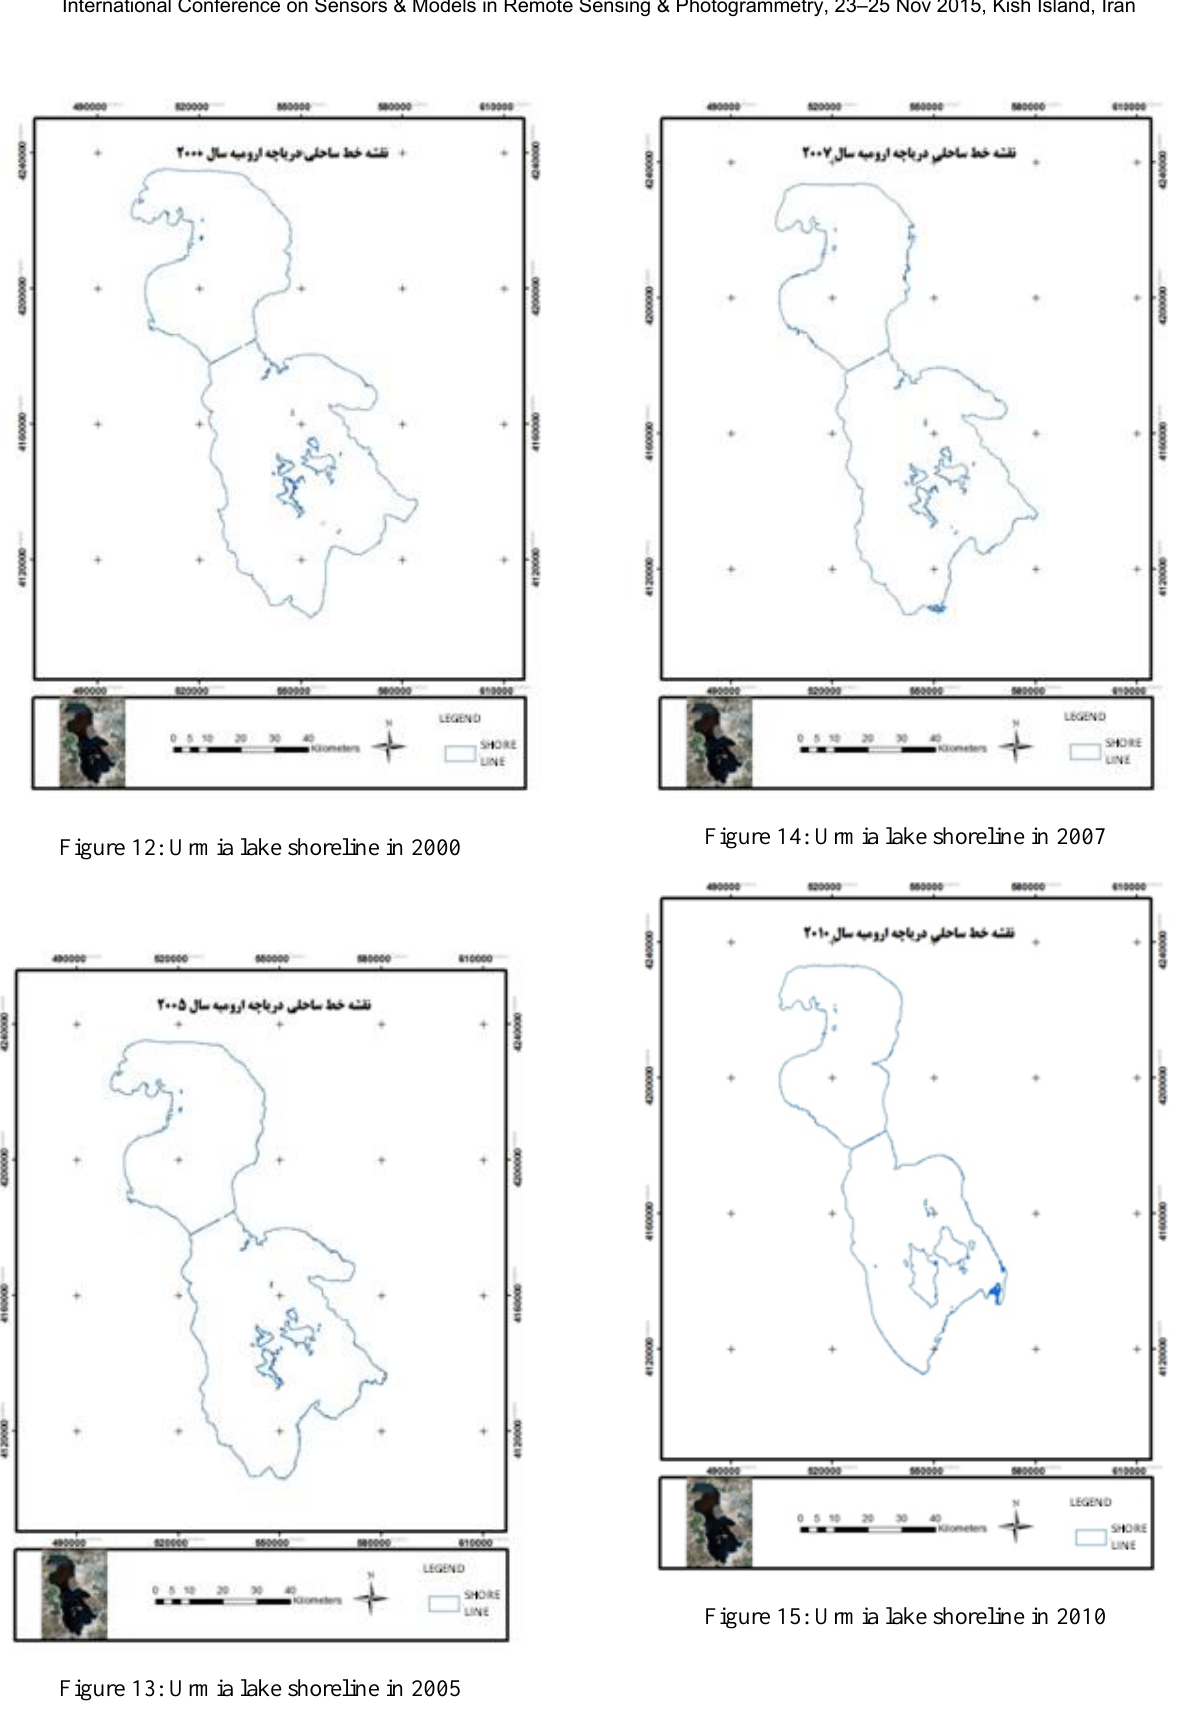
Figure 13: Urmia lake shoreline in 2005